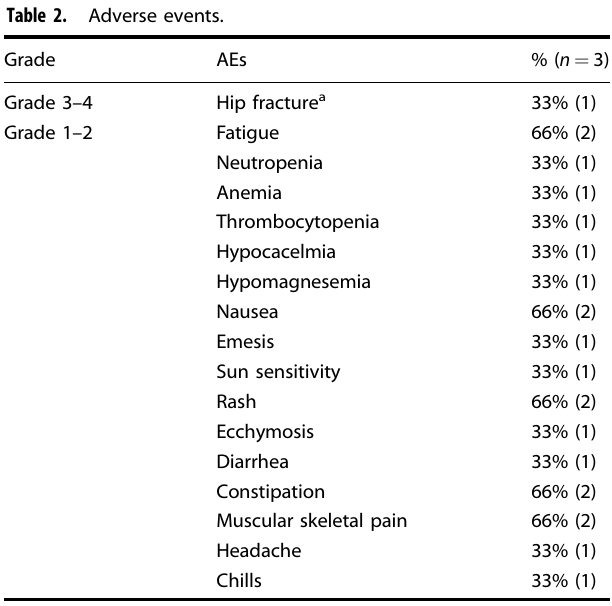
Table 2. Adverse